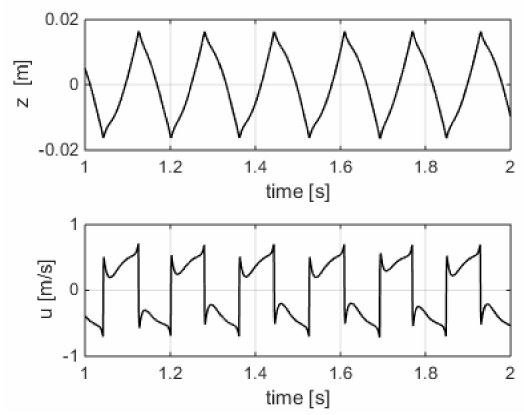
Figure 15. The waveforms of the piston displacement (z) and the piston speed